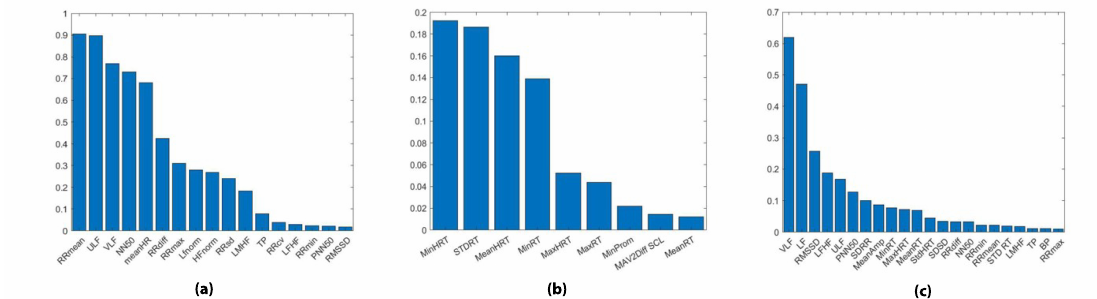
Figure 6. Regression coefficients for deterministic features using least absolute shrinkage and selection operator (LASSO) on: ( a ) ECG features; ( b ) GSR features; ( c ) multimodal (ECG and GSR)